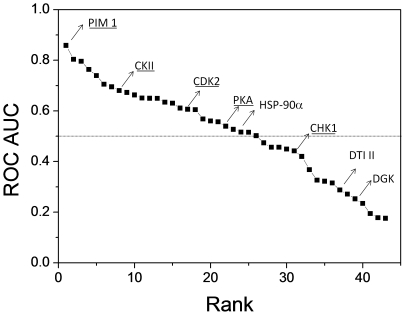
Similarity of ATP-binding proteins to bovine synapsin I.ATP-binding proteins present in at least 5 copies in the sc-PDB dataset (n = 43) are ranked by decreasing ROC score (area under the ROC curve), iteratively computed for each protein from the SiteAlign [41] alignment (d2 score) to the ATP-binding site of bovine synapsin I (PDB entry 1aux). Protein kinases are underlined. PIM 1, Proto-oncogene serine/threonine-protein kinase Pim-1; CK II, Casein kinase II subunit alpha; CDK2, Cell division protein kinase 2 (cyclin-dependent kinase 2) ; PKA, cAMP-dependent protein kinase catalytic subunit alpha (Protein kinase A); HSP-90α, Heat shock protein HSP 90-alpha; CHK1, Serine/threonine-protein kinase Chk1; DTI II, DNA topoisomerase II, DGK, Diacylglycerolkinase).